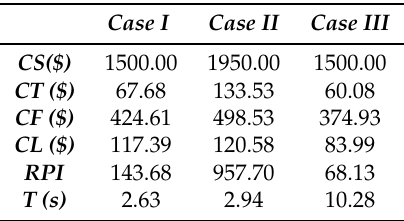
Table 2. Solutions (values: 10 3